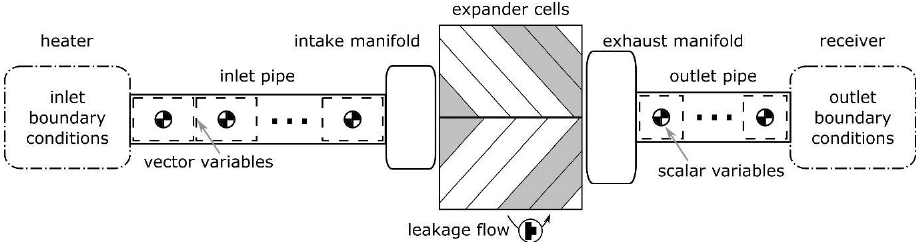
Figure 2. Modelling approach for the 1D chamber model (1D Ch. Model) [10].